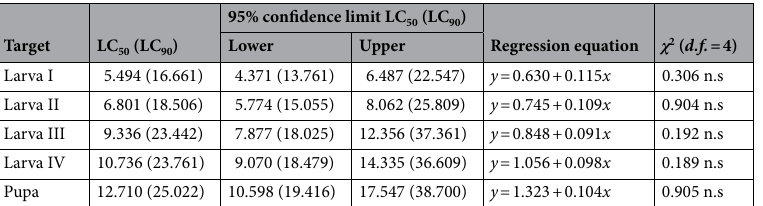
Table 2. Larval and Pupal toxicity effect of ZnO NPs synthesized using Lawsonia inermis against the malarial vector Anopheles stephensi. No mortality was observed in the control. LC 50 = lethal concentration that kills 50% of the exposed organisms. LC 90 = lethal concentration that kills 90% of the exposed organisms. χ 2 = chi-square value. d.f. = degrees of freedom. n.s . = not significant (α = 0.05).